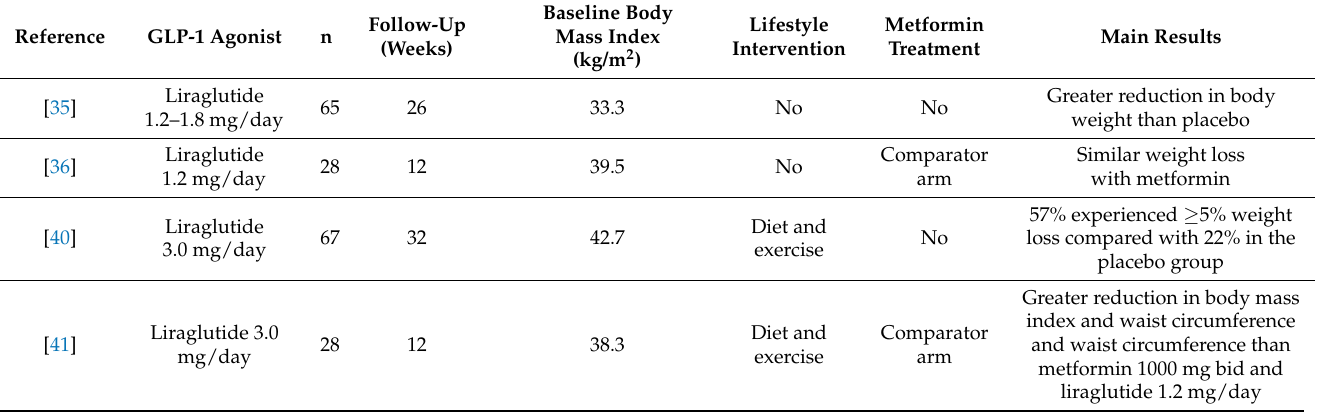
Table 1. Major studies evaluating the effects of glucagon-like peptide-1 (GLP-1) receptor agonists on obesity in patients with polycystic ovary